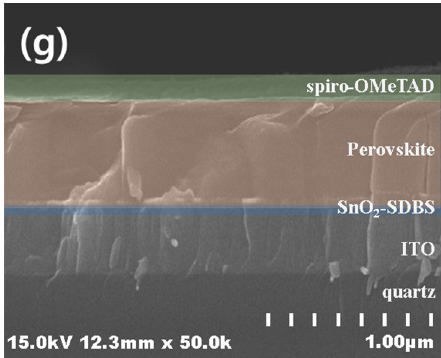
Figure 2. SEM images of mixed-anion perovskite according to FABr concentration ( a ) FABr-0, ( b ) FABr-5, ( c ) FABr-10, ( d ) FABr-15, ( e ) FABr-20, ( f ) FABr-25, ( g ) Cross-section of a device with individual layers shown in different colors.